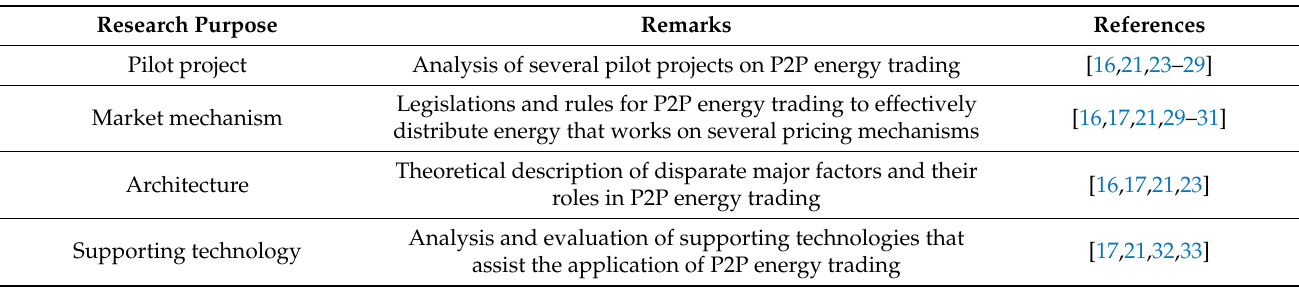
Table 1. Summary of related review papers related to peer-to-peer.